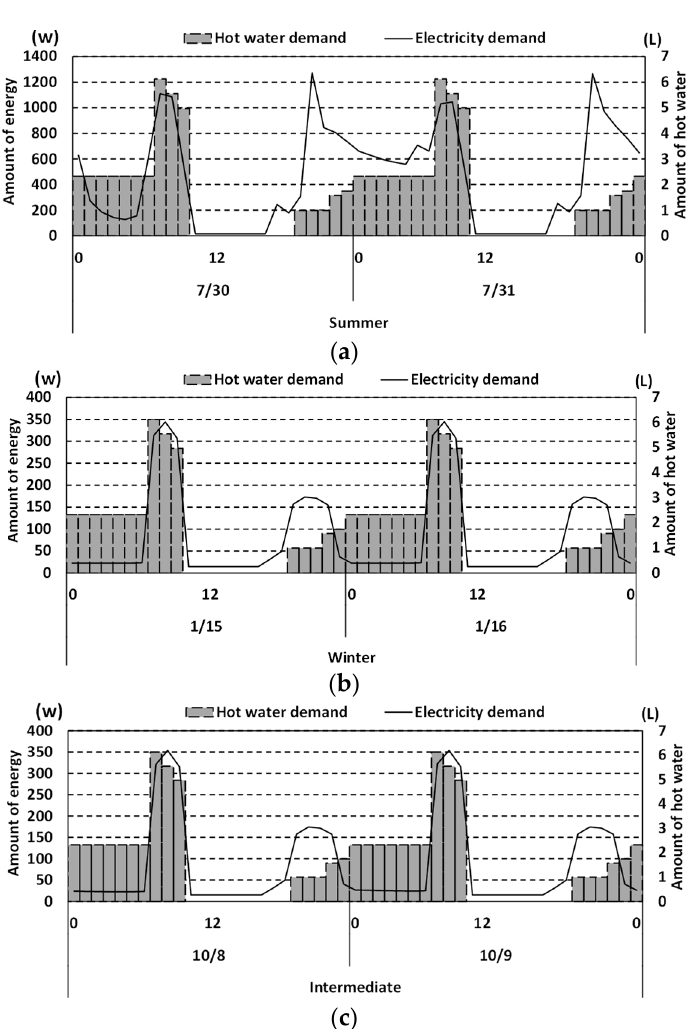
Figure 7. Representative daily data of electricity demand and hot water demand of household 1 in each season. ( a ) Data in summer; ( b ) Data in winter; ( c ) Data in intermediate seasons.